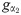
Various cell responses in the simulated gα2-null cell and ric8-null cells.Top: Dose dependent dissociation at steady state. Middle: Time course of RBD dynamics. Bottom: refractoriness.